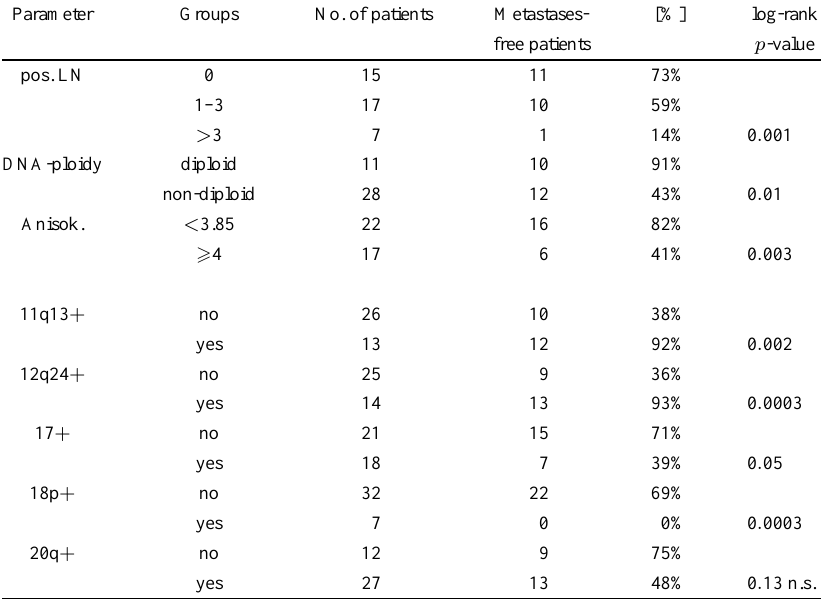
Results from Kaplan–Meier analyses with the number of patients per group, the number of metastases- free patients and the significance values Parameter Groups No. of patients Metastases-